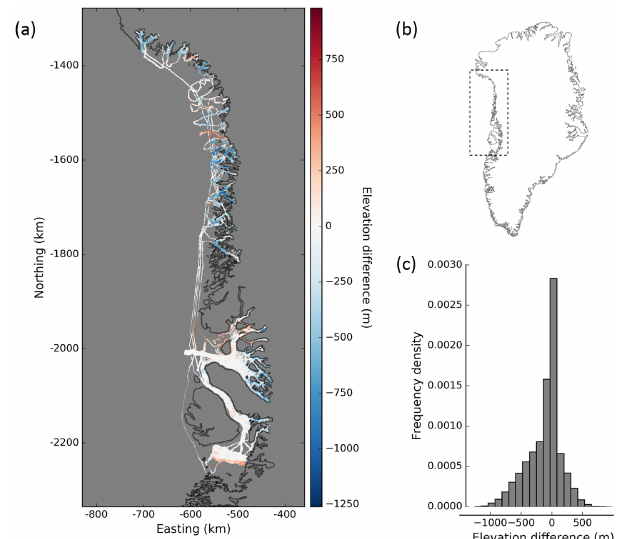
Figure 9. Bed elevation differences (OBS1516 minus Bed2013) (a) at all surveyed locations along the west Green- land coast (b) and as a frequency distribution (c) . Red regions in (a) indicate bathymetry elevation overestimation by Bed2013 (too deep), with blue regions illustrating underestimation (Bed2013 too